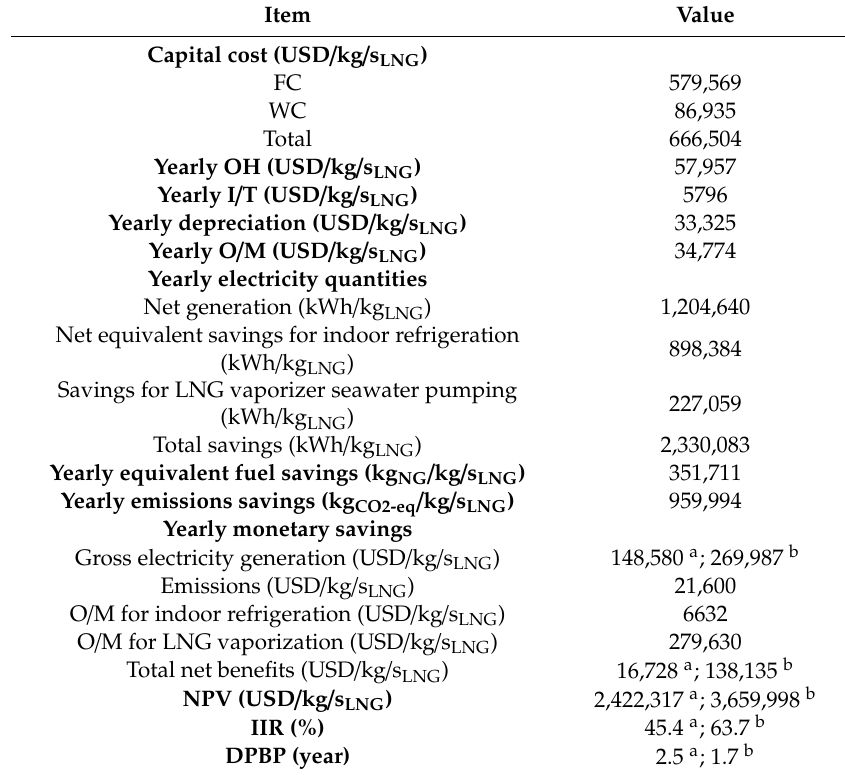
Table 9. Monetary and environmental analysis results for the poly-generation system per kg / s LNG .